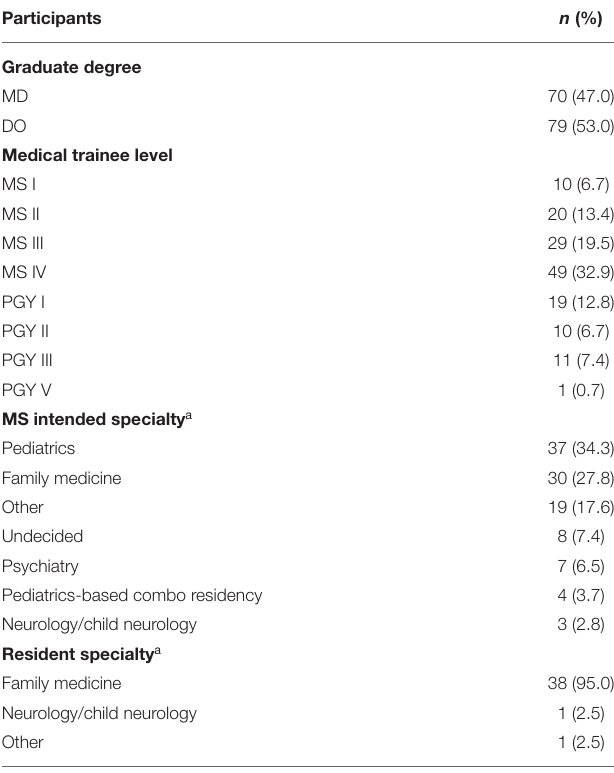
TABLE 1 | Participant characteristics: graduate degree, medical training level, and medical specialty area of the participants ( N =